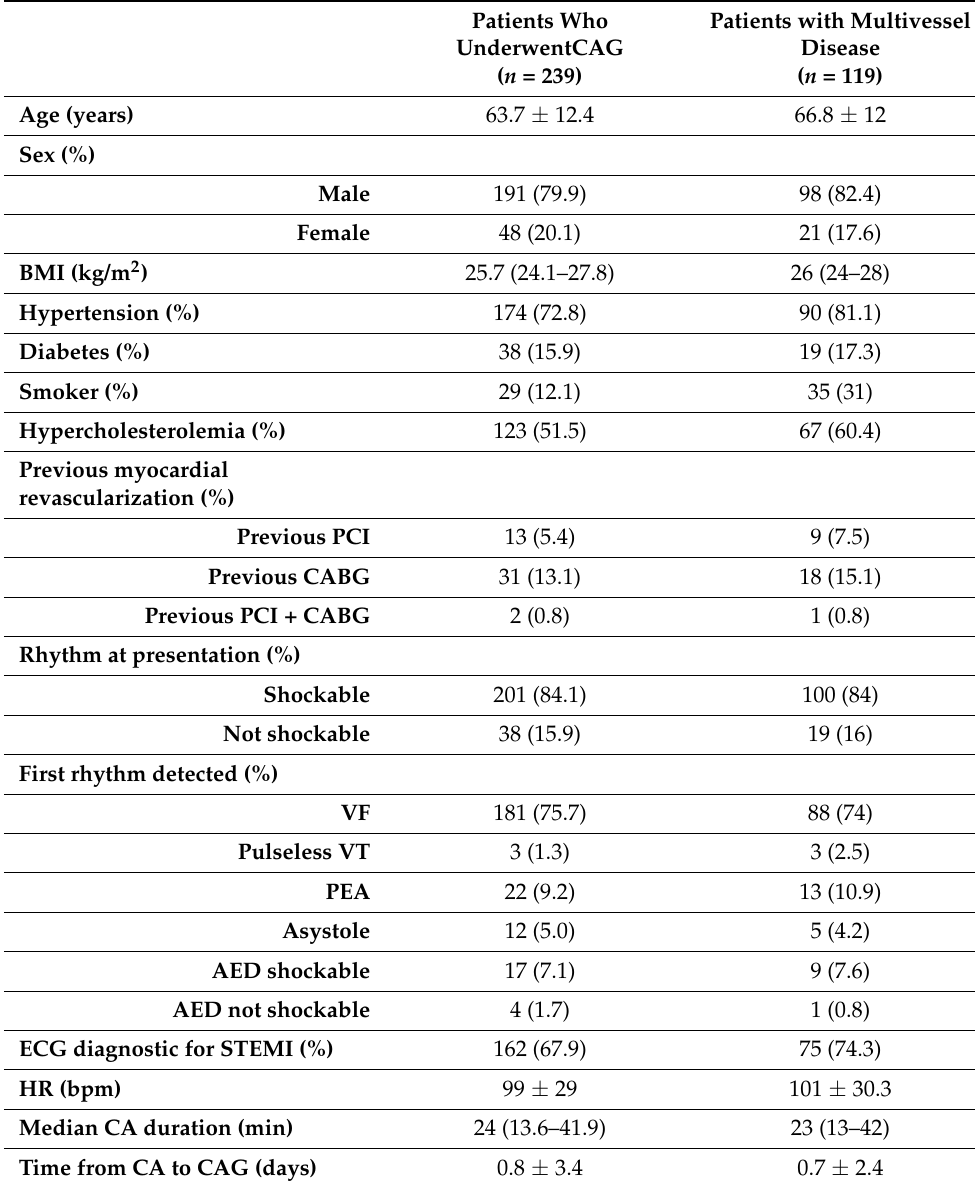
Table 1. Characteristics of patients resuscitated from OHCA who underwent a coronary angiography and with multivessel disease.